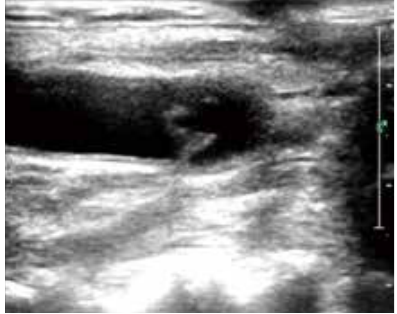
Figure 1 The longitudinal section of the right common carotid artery shows the irregular intima due to a tear.